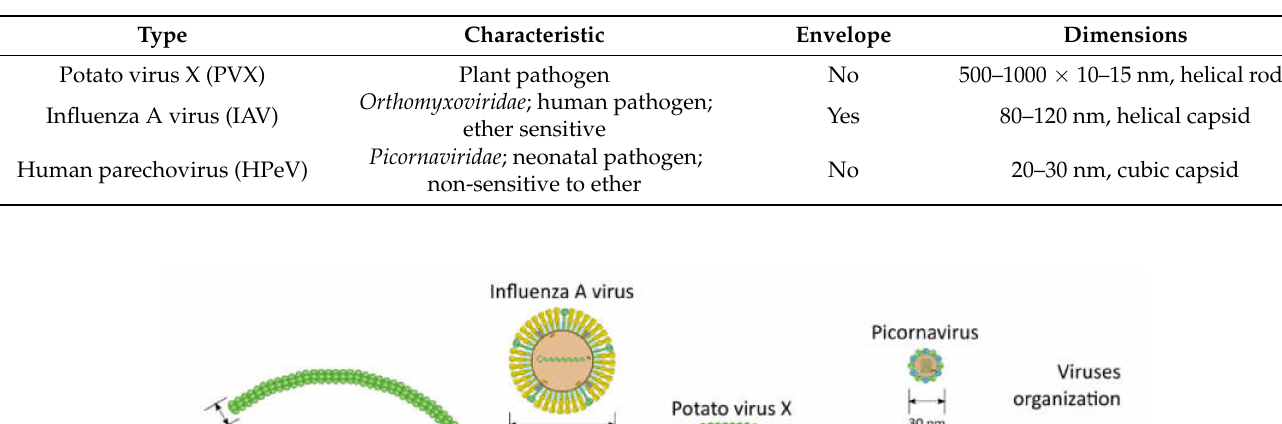
Table 1. Viruses used in this work [14,15].